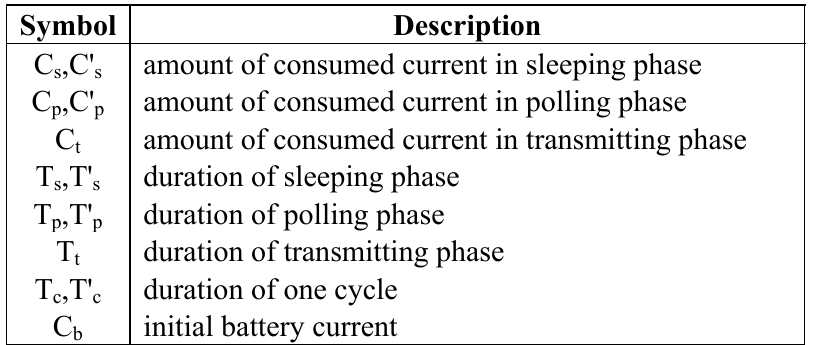
Table 2. List of